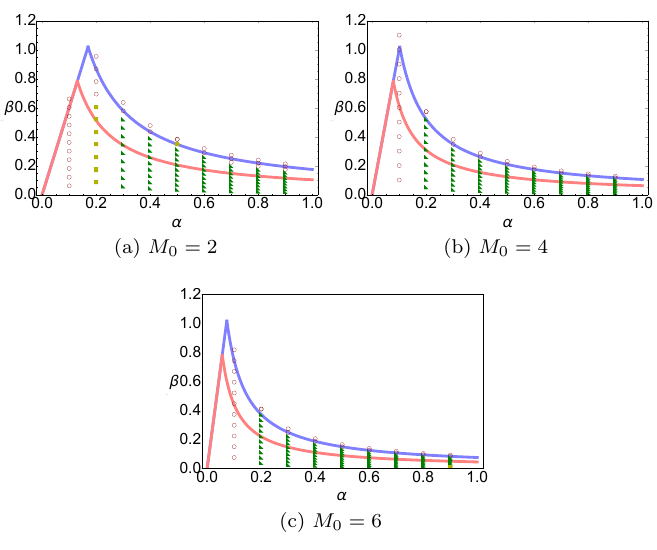
Figure 9. Practical stability analysis of the scheme B for β = 0 . 1 kβ nec ( α,M 0 ), 1 ≤ k ≤ 11, in dependence on α , for M 0 = 2 , 4 , 6 and τ = αh/c s